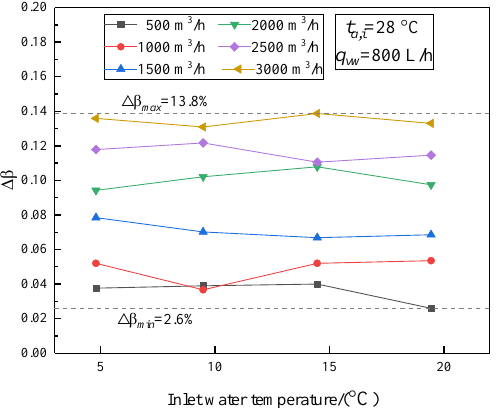
Figure 9. Variation of Δβ with inlet water temperature under different wate r flow rates. 3.1.2. Heat Transfer Rate for Different Flow Rates and Inlet Water Temperatures The quantity and efficiency of heat transfer with the inlet water temperature under different air flow rates were studied. As shown in Figure 10, the water flow rate was maintained at 800 L/h. With the increase of inlet water temperature, the temperature difference between the air and water sides decreased. The heat transfer rate decreased linearly for different air flow rates. When the air low rate was 3000 m 3 /h and the inlet water temperature was 5 °C, the maximum heat transfer rate was 9.29 kW. Meanwhile, with the increase of inlet water temperature, the larger the air flow rate was, the faster the heat transfer rate decreased. 5